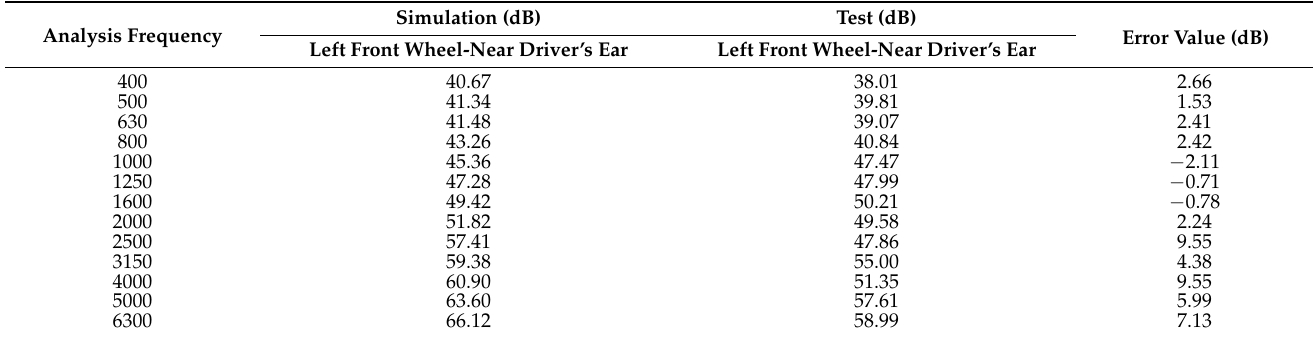
Table 4. Left front wheel drive test results.